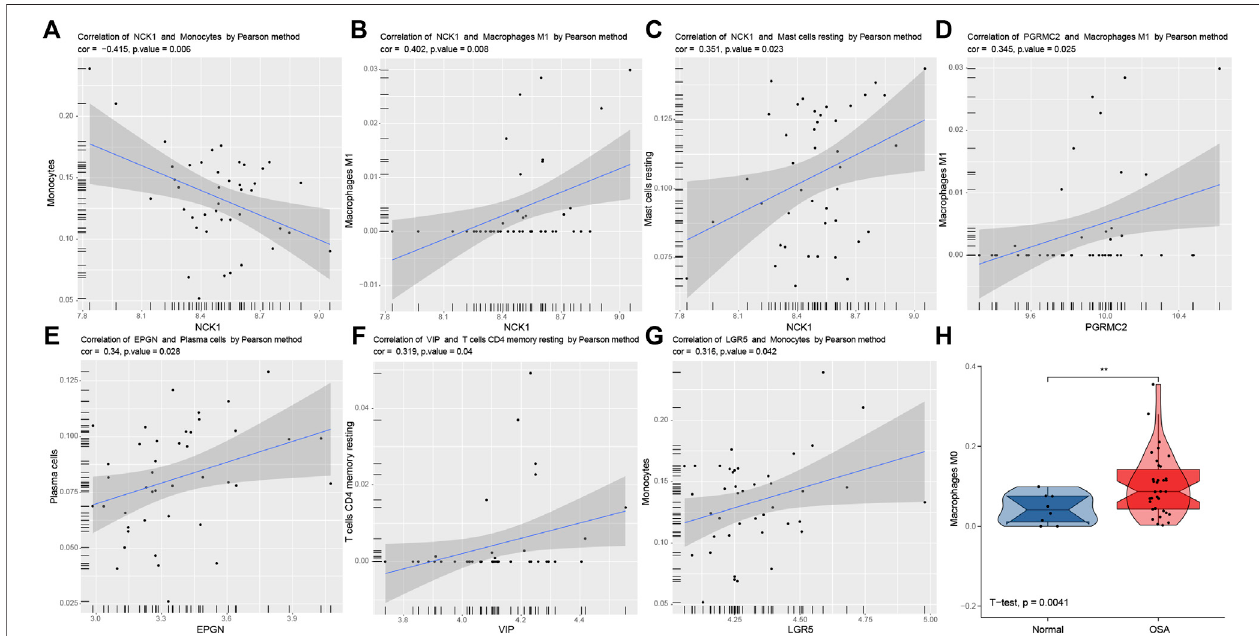
FIGURE 9 | Correlation analysis between predictors and immune cells. Signi fi cantly correlations between predictors and immune cells: NCK1 and monocytes (A) , NCK1andmacrophagesM1 (B) ,NCK1andmastcellsresting (C) ,PGRMC2andmacrophagesM1 (D) ,EPGNandplasmacells (E) ,VIPandTcellsCD4memoryresting (F) ,andLGR5andmonocytes (G,H) .ViolinplotsoftheabundanceofmacrophagesM0.Theboxplotsintheviolinindicatethemedianandinterquartilerangeofthedata distribution.